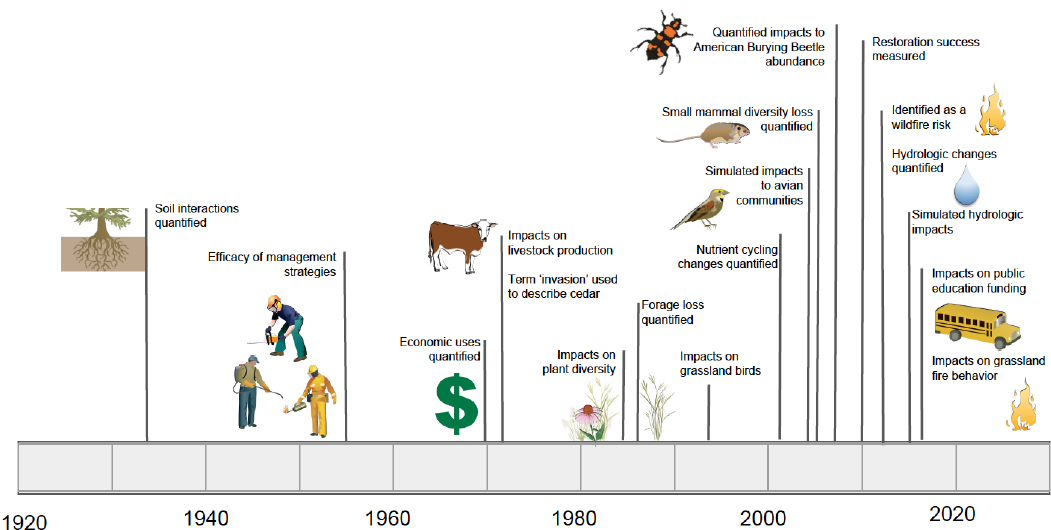
Figure 1. A chronological timeline detailing the progression of scientific understanding of redcedar impacts on the natural system and, ultimately, on societal systems. Notably, the concerns were initially focused on the loss of economic value and ecological impacts. Concerns specifically regarding impacts on water resources began around 2010, concurrent with the episodic droughts and extreme water stress that affected the study region.